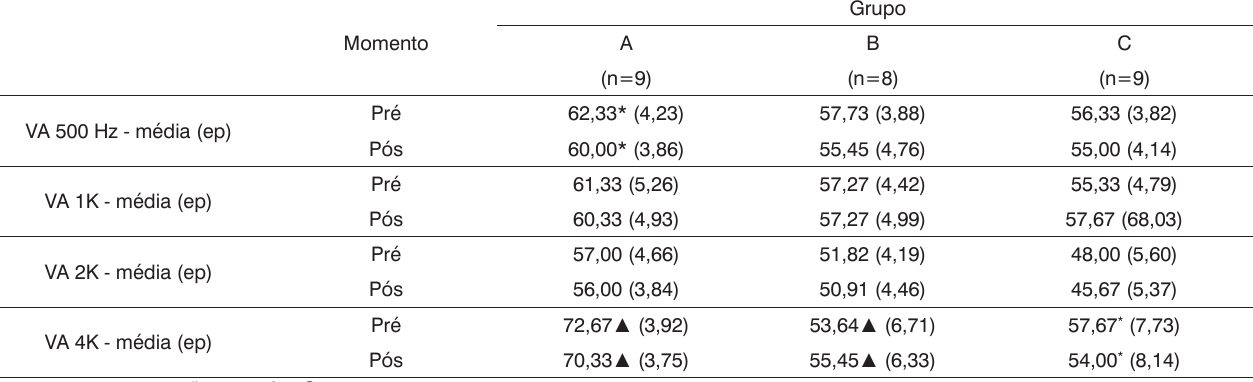
§ p<0,05 na comparação entre A e